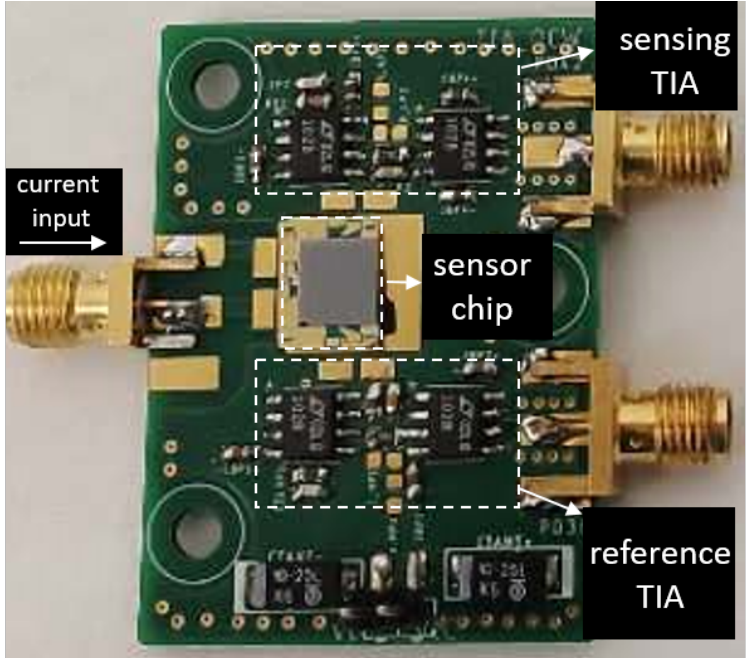
Figure 7. PCB consisting of the TIAs for the sensing photodiode and the reference photodiode. The fabricated sensor chip is mounted on the PCB and the contacts pads of the LED/photodiodes are connected to the board with wire